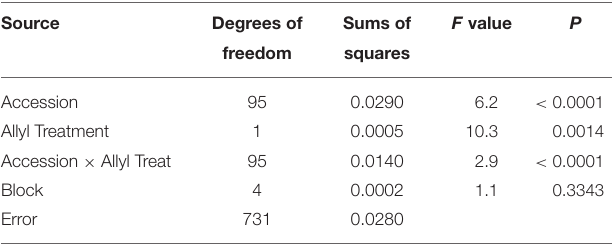
TABLE 2 | Allyl treatment affects Arabidopsis plant